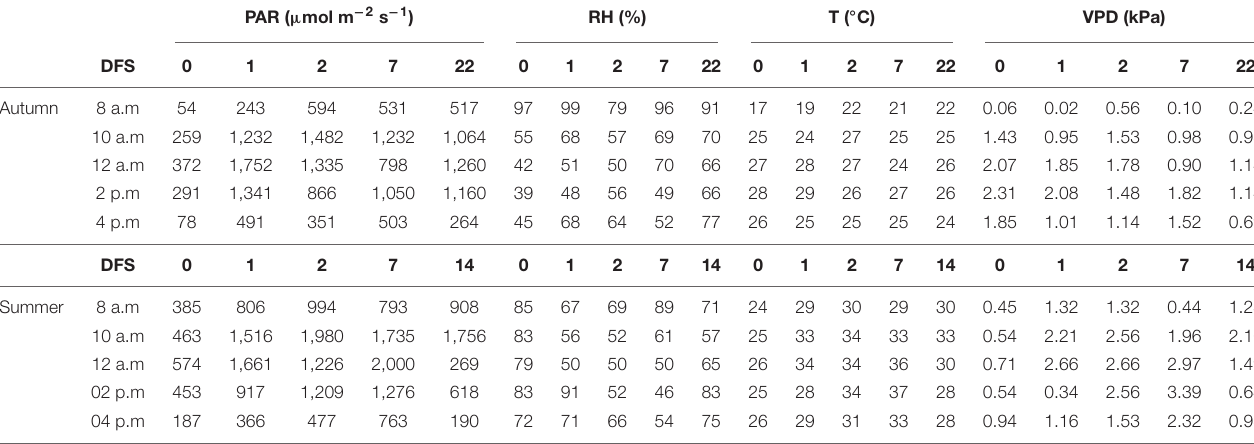
TABLE 1 | Photosynthetic active radiation (PAR), relative humidity (RH), air temperature (T air ), and vapor pressure deficit (VPD) recorded for days of ecophysiological measurements of young coffee plants transferred from nursery to full